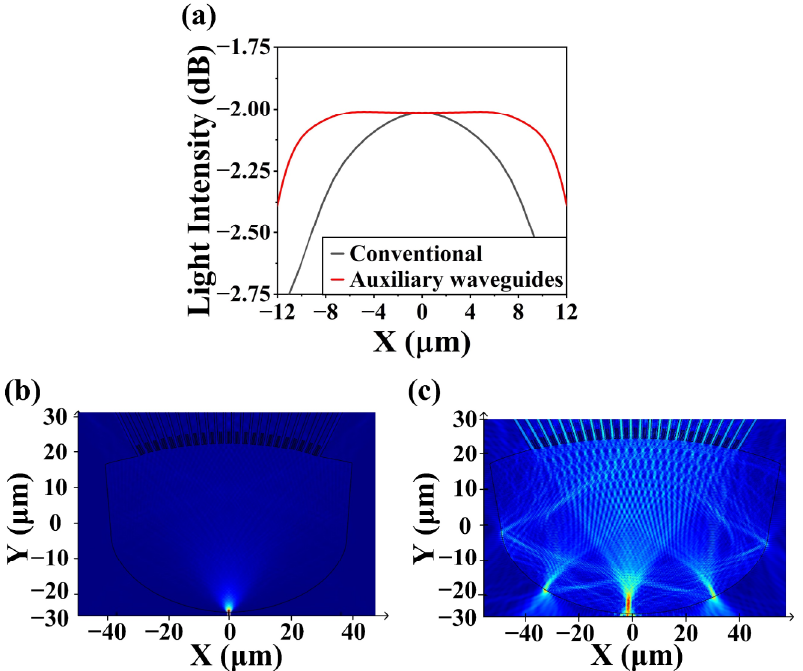
Figure 5. ( a ) Light intensity distribution along the image plane with conventional design and uni- formity-improved design. Calculated electric field distribution of ( b ) the input star coupler and ( c ) the output star coupler.